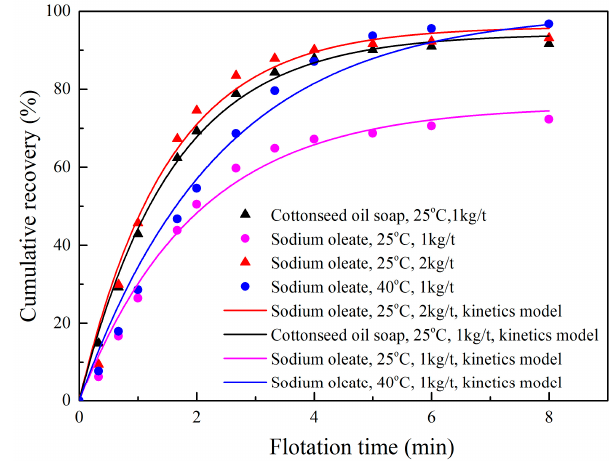
Figure 1. Flotation kinetics of sedimentary phosphate ore under different conditions.